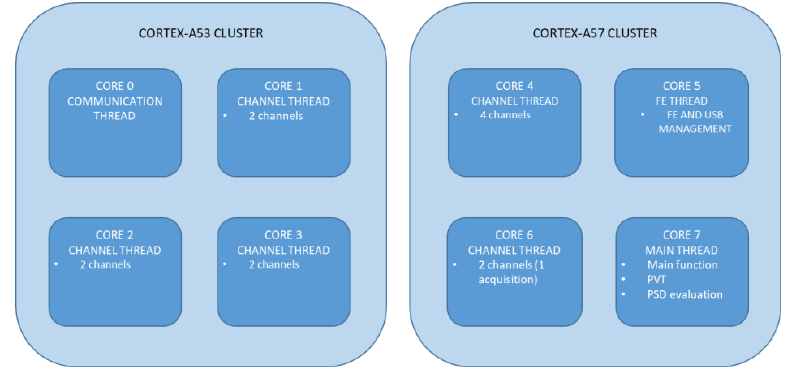
Figure 2. Thread allocation of NGeneApp on the cores of the Samsung Galaxy S6.